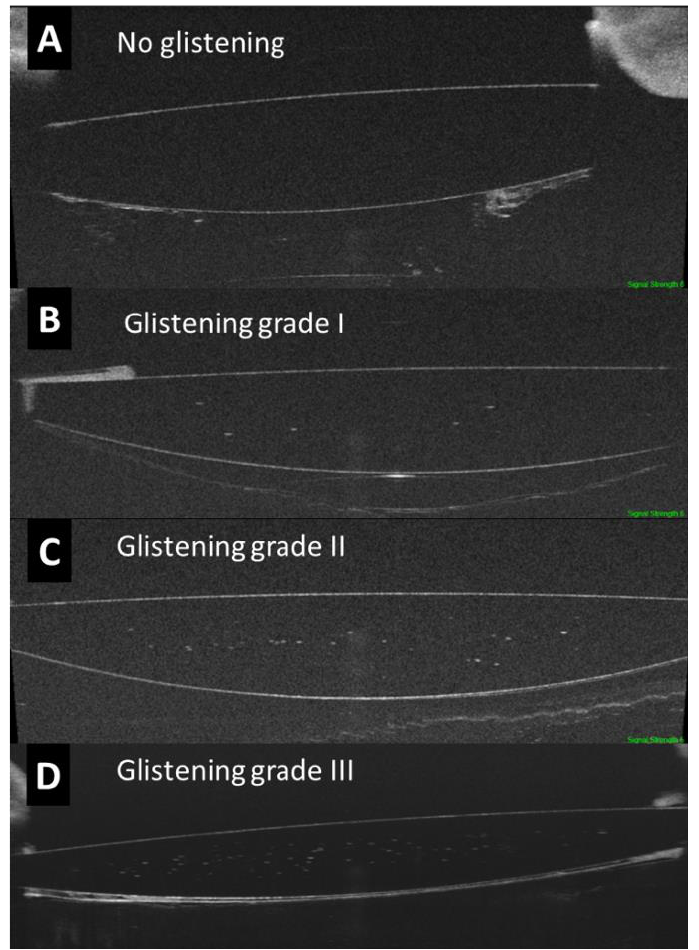
Figure 2. Optical coherence tomography of the optic of the intraocular lens (IOL) assessing the glistening and categorized into 4 groups based on the severity in the amount of hyperreflective foci or microvacuoles.